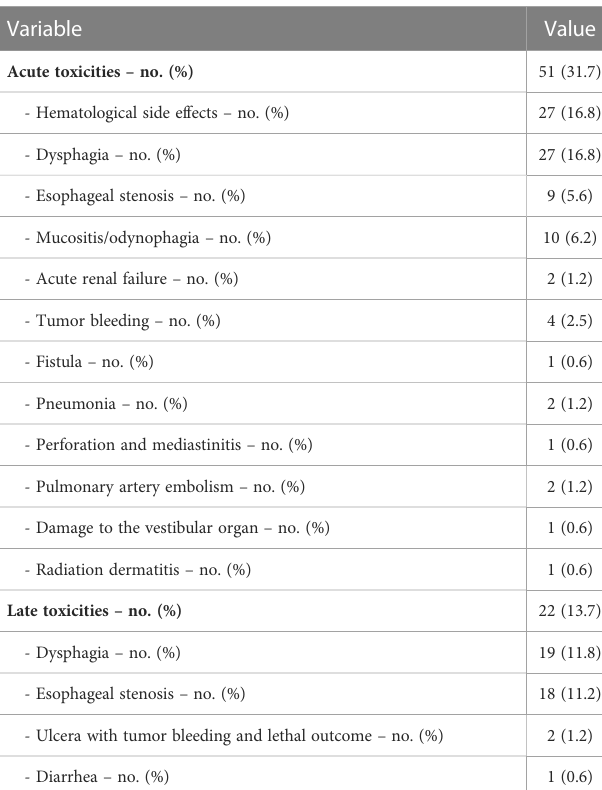
TABLE 4 Acute and late severe and life-threatening toxicities (grade 3 and 4 according to CTCAE v5.0) of (chemo)radiotherapy in elderly patients with SCC of the